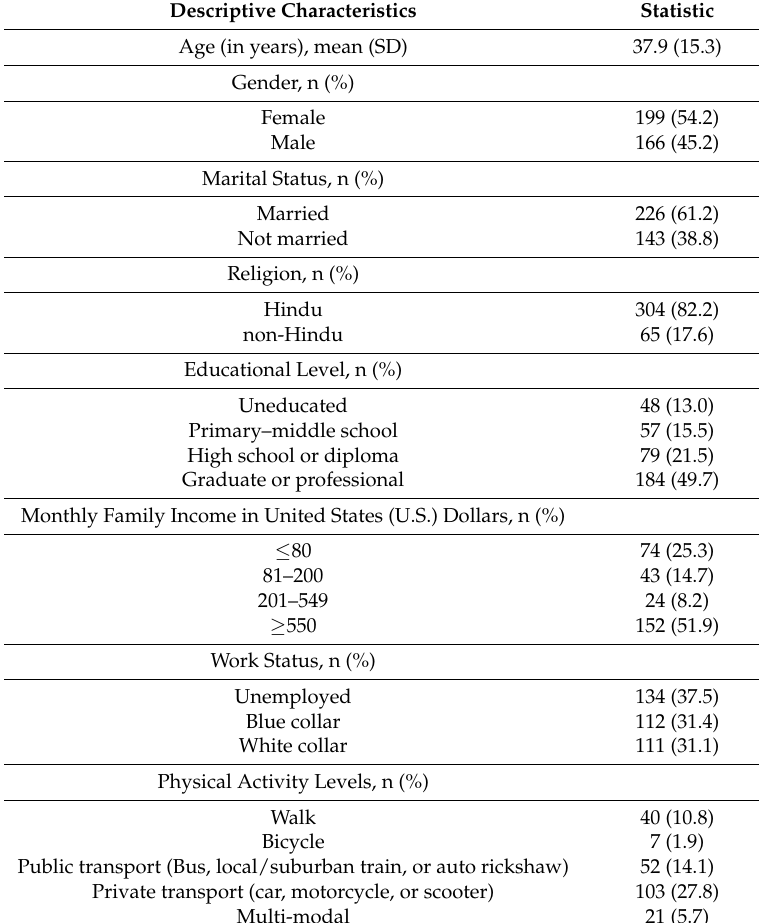
Table 1. Descriptive statistics of the sample population (n =